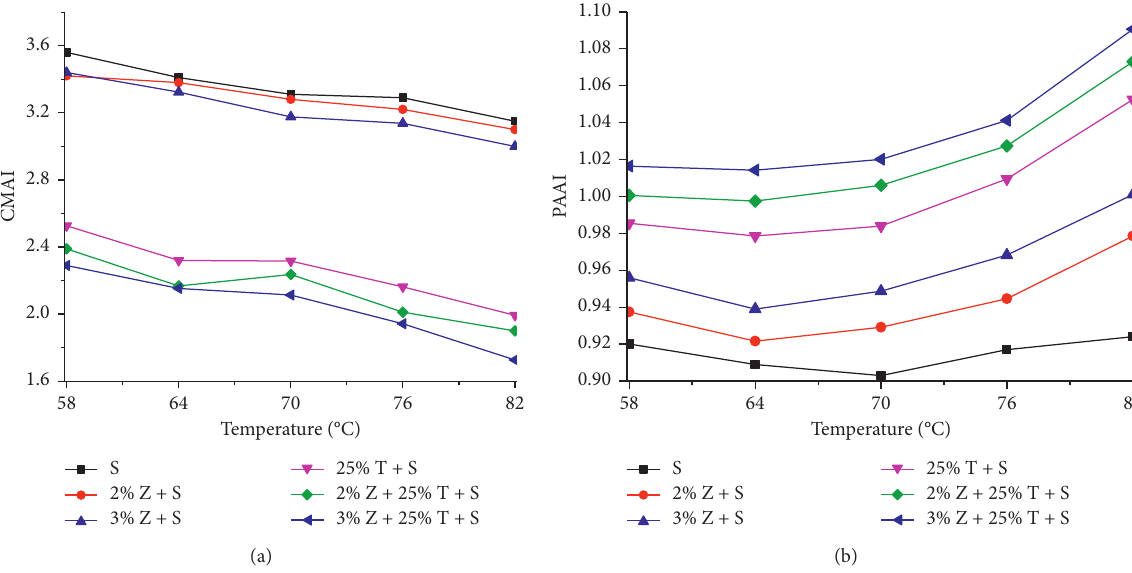
Figure 5: Effect of different content of nano-ZnO (Z) and TLA (T) on rheological properties of SBS asphalt (S) after long-term aging. (a) Complex modulus aging index for asphalt. (b) Phase angle aging index for